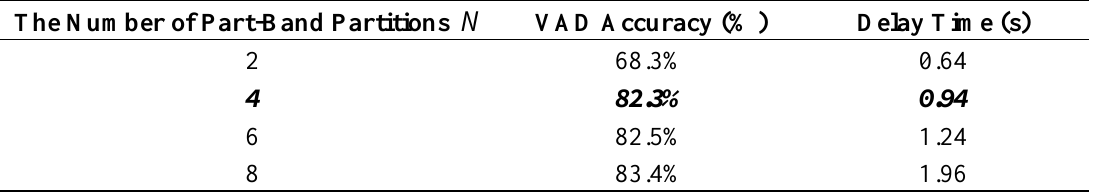
Table 1. The number of part-band partitions related to the VAD accuracy and delay time. The Number of Part-Band Partitions N